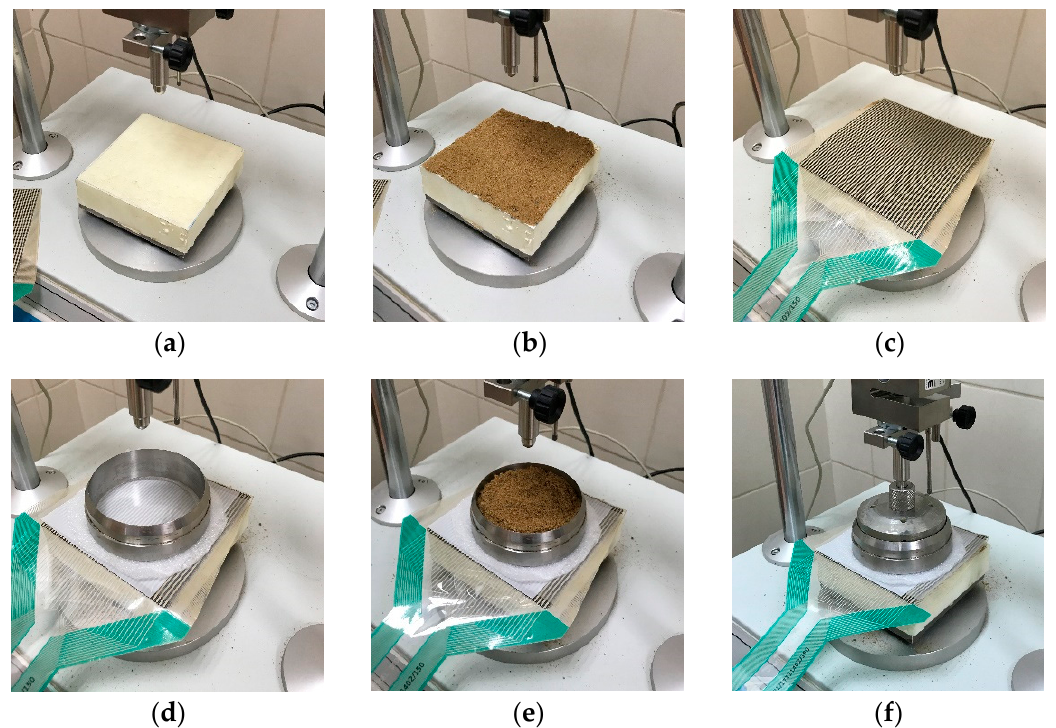
Figure 10. Calibration of tactile and color film sensors. ( a ) Steel plate (thickness 5 mm) and extruded polystyrene (thickness 15 mm) layer. ( b ) Layer of sand. ( c ) Tactile sensor. ( d ) Color film sensor and steel ring with flexible and soft dilatation ring placed between the steel ring and sensor. ( e ) Filing the ring with sand. ( f ) Placing the steel piston and starting the test.